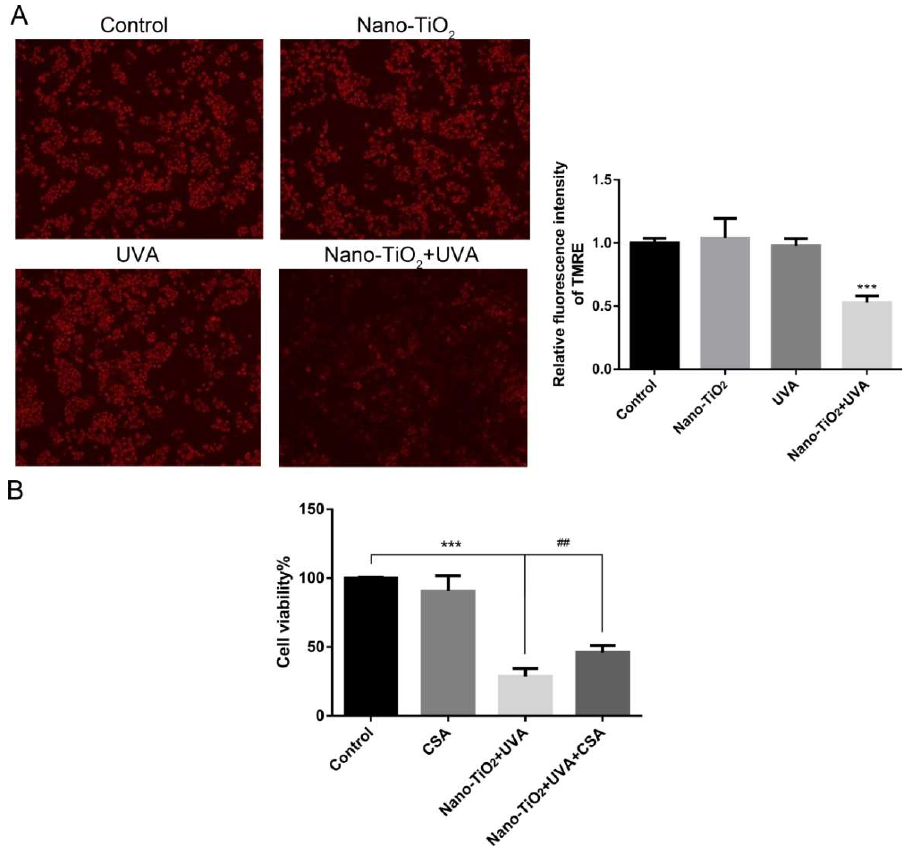
Figure 5. The effect of mPTP on phototoxicity of nano-TiO 2 . ( A ) HeLa cells were treated with